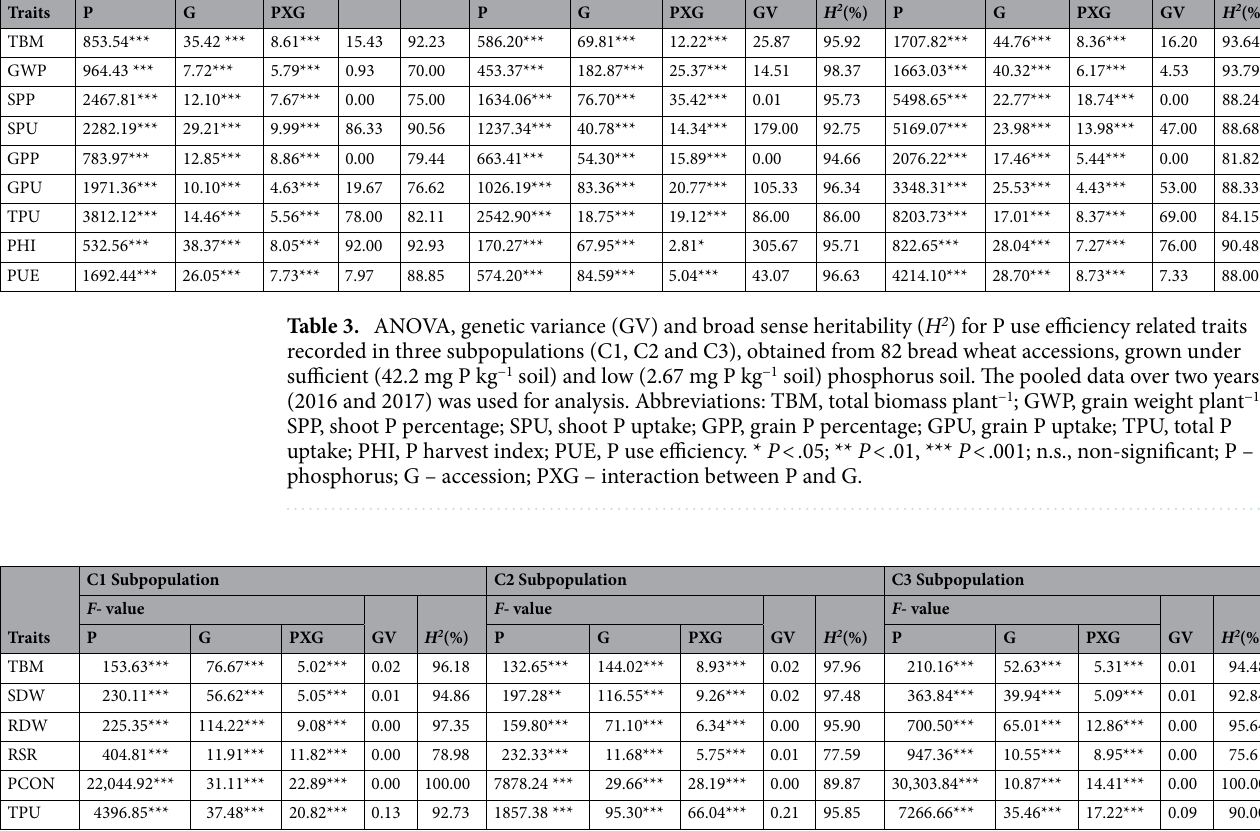
cient and low P. Compared with subpopulations C1 and C3, the traits in C2 exhibited highly significant (P < 0.05) positive or negative association in both soil (Fig. 3) and hydroponics (Fig. 4) experiments. In soil experiments in the C2 subpopulation, the grain weight per plant showed higher correlation with PUE (r = 0.88) and total biomass (r = 0.83), the shoot P concentration exhibited correlation with shoot P uptake (r = 0.90) and grain P concentration (r = 0.82) and between PHI and PUE (r = 0.97) under sufficient P. In low P soil, C2 subpopula- tion showed higher correlation for grain weight per plant with PUE (r = 0.90) and grain P uptake (r = 0.98), and between PHI and PUE (r = 0.96) (Fig. 3). Likewise, in the hydroponically grown plants, the correlation values were higher in C2 subpopulation as compared to C1 and C3 under both sufficient and low P condition (Fig. 4). Marker‑trait association. A total of 78 MTAs (having P -value less than 0.0001) were found in both, soil (Fig. 5) and hydroponics (Fig. 6) experiments under sufficient P (SP) and low P (LP) levels for 13 different quan- titative traits (11 traits in soil and four traits in hydroponics; two were common) (Supplementary Fig. S4–S5). Out of 78 SNPs, 69 unique MTAs were identified in soil experiment (47 MTAs under SP and 27 MTAs under LP; five were common between SP and LP though the traits were different for three MTAs) (Supplementary Table S11) whereas 9 unique MTAs were identified in hydroponics experiment (3 MTAs under SP and 7 MTAs under LP; one was common between SP and LP for TBM) (Supplementary Table S12). Maximum number of significant MTAs having P -value less than 0.0001 were present on D (28) genome followed by B (26) and A (24) genome (Fig. 7A). The significant MTAs identified in soil experiment were associated with all 11 traits such as TBM (3), GWP (9), SPP (10), SPU (8), GPP (4), GPU (4), TPU (3), PHI (8), PUE (9), PSSI (1), PAE (1) under SP while with six of eleven traits, that is, GPU (10), GWP (8), PAE (1), PUE (5), PHI (4) and PSSI (1) under LP. Similarly, in hydro- ponics experiment, the significant MTAs were associated with three of seven traits, they were TPU (1), SDW (2)